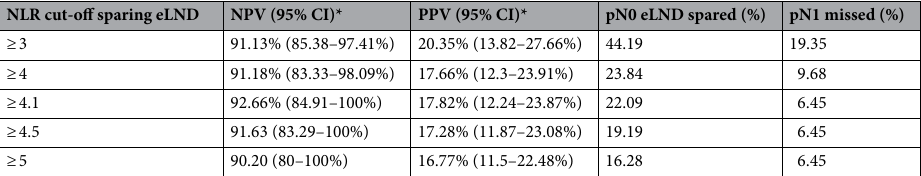
Table 3. Different NLR cut-offs validated internally using the bootstrapped dataset (n = 200). NLR neutrophil- to-lymphocyte ratio, eLND extended lymphadenectomy, NPV negative predictive value, PPV positive predictive value. *Values calculated for bootstrapped dataset (n = 200 × 205).